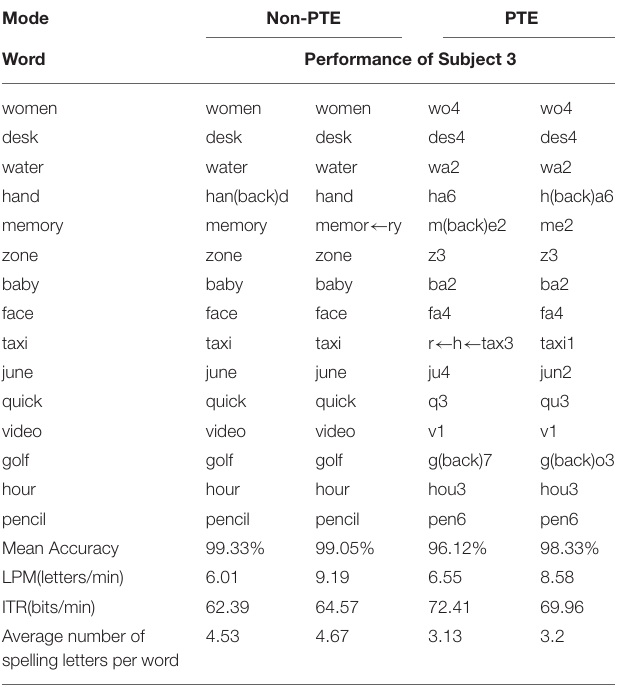
TABLE 6 | The detailed performance of character input for Subject